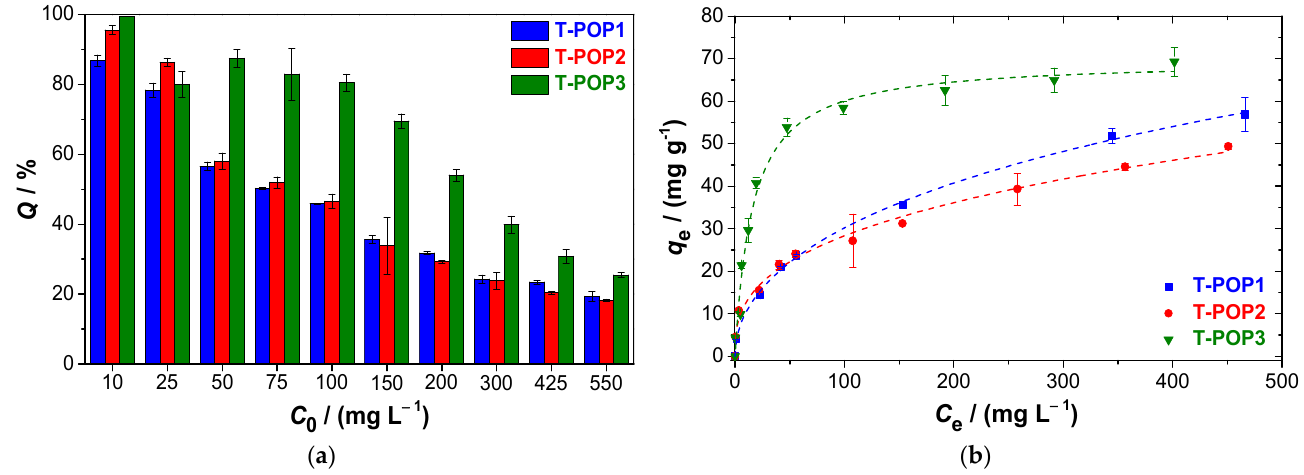
Figure 9. Removal of MB from water: ( a ) effect of initial concentration on adsorption efficiencies and ( b ) adsorption isotherms by different polymers (25 °C). The dashed curves represent the fitting of different models to the experimental data: Hill (T-POP1), Freundlich (T-POP2), and Langmuir (T-POP3) equations.